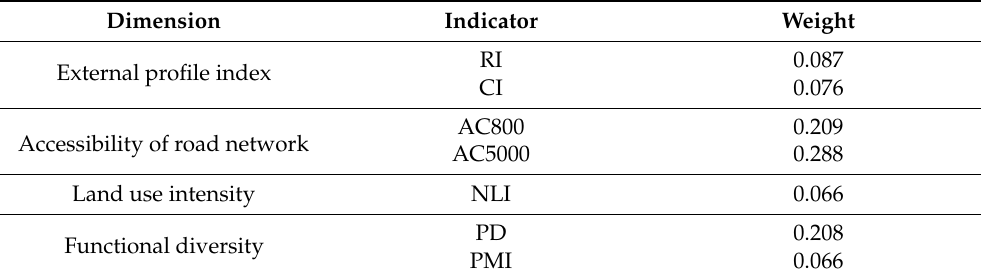
Table 5. Weights of compactness measurements. Dimension Indicator Weight